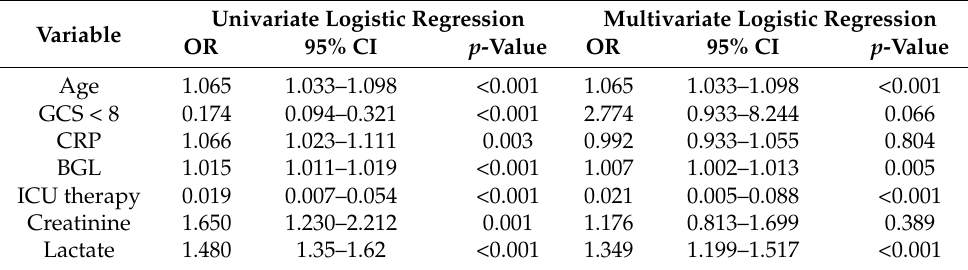
Table 3. Independent predictors of mortality identified with logistic regression analysis includ- ing initial glucose level and other statistically significant variables, which can easily be assessed at presentation.